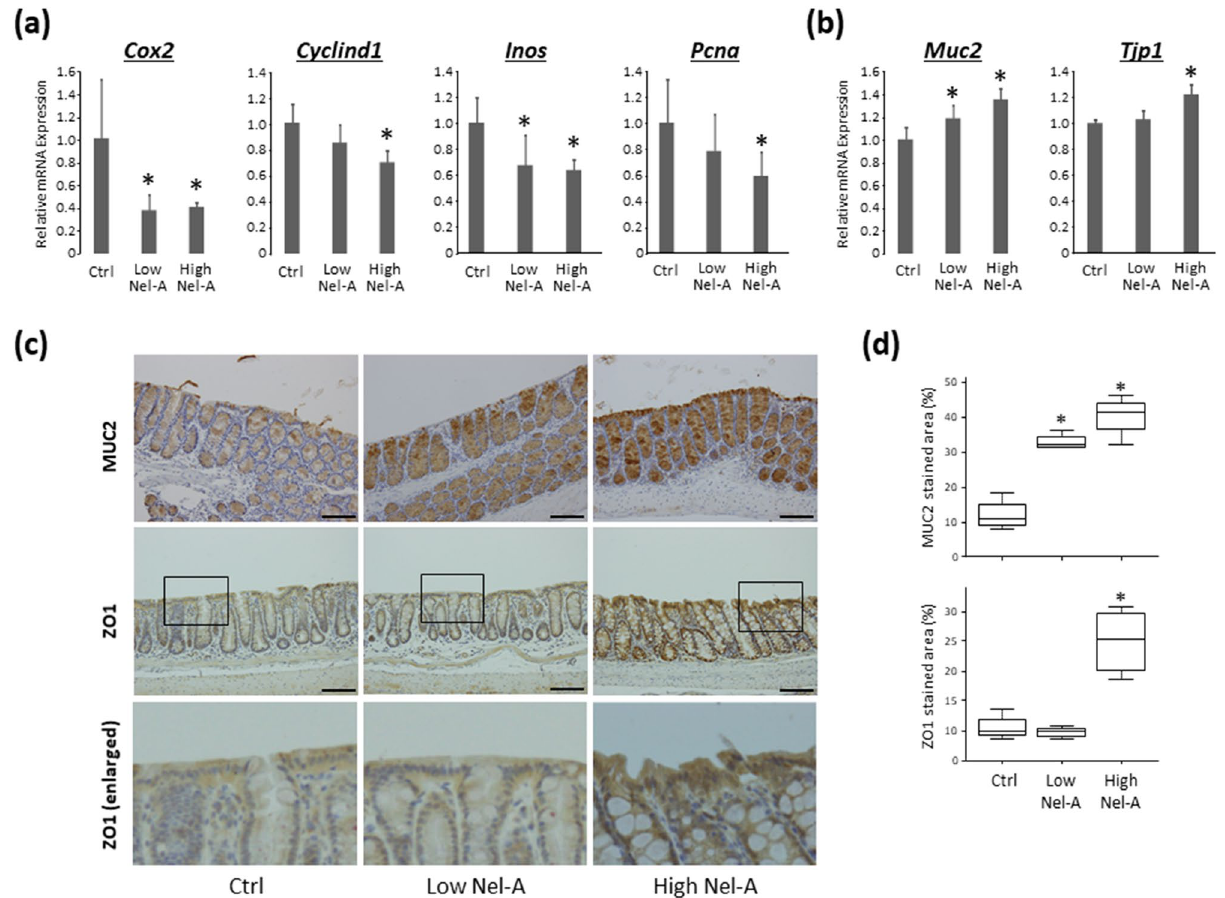
Figure 3. Effects of nelumal A on cell proliferation and barrier function in the colon of carcinogenesis model mice. The mRNA expression levels of Cox2, Cyclind1, Inos, Pcna ( a ), Muc2, and Tjp1 ( b ) in the colonic mucosa were measured by quantitative real-time reverse transcription PCR with specific primers. Parallel amplification of 18S was used as the internal control. Each column represents the mean ± SD. Statistical analyses were performed using one-way ANOVA followed by Tukey–Kramer multiple comparison test. n = 6. ( c ) Immunohistochemical analyses for MUC2 and ZO1, with enlarged pictures of the section from enclosed areas with square, in the colon of the experimental mice. Bars, 100 μm. ( d ) Data for quantitative analysis of immunohistochemistry were expressed as box-and-whisker plots with median values and 10, 25, 75, and 90 percentiles. Asterisk indicates statistically significant differences compared to AOM/DSS-treated control group; P < 0.05. Ctrl, control. Nel-A, nelumal